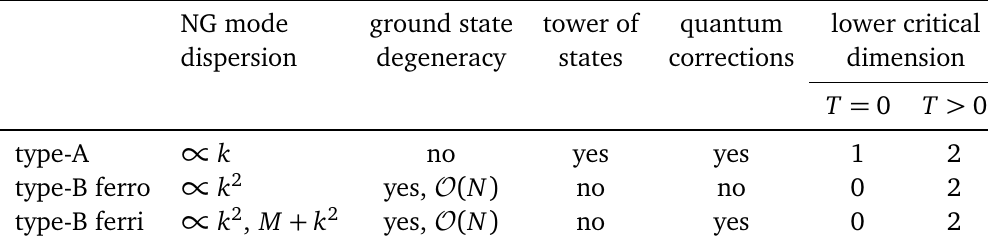
Table 4.3: The effect of different types of Nambu–Goldstone modes on the emergence of long-range order. The accurate forms of the dispersion relations can be found in Eqs. 3.19. Indicated for each case are the presence or absence of ground state degeneracy and of a tower of states at k = 0, whether or not the ground state is affected by quantum corrections, and the lower critical dimensions for both zero and non-zero